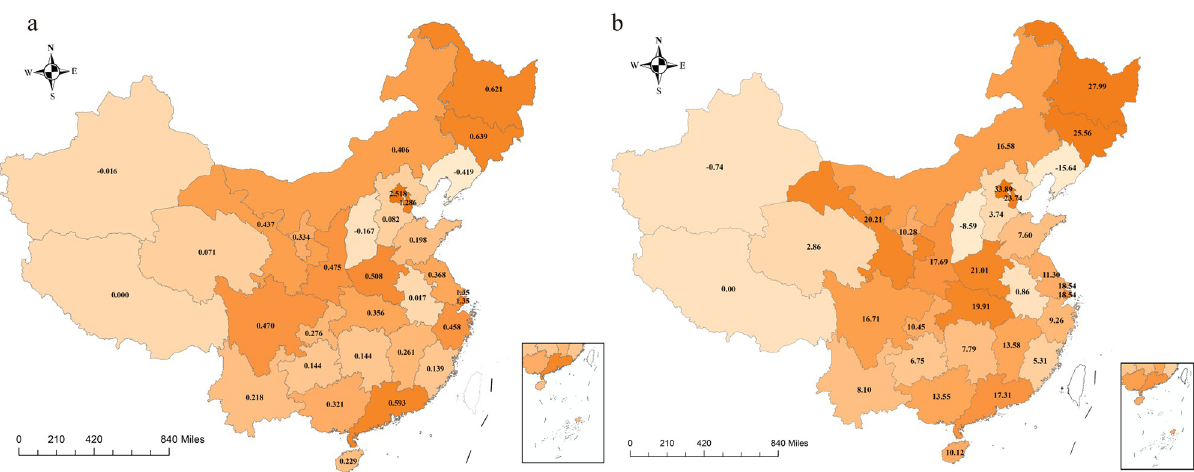
Fig 3. Accumulative impacts of COVID-19 on OEH visits per capita in mainland China. (a) This panel plots the total loss of OEH visits per capita from February 2020 to March 2021 by province. The darkness of each block represents the total loss of total OEH visits per capita of each province from February 2020 to March 2021 Tibet was excluded because of missing data. (b) This panel plots the relative loss of OEH visits per capita from February 2020 to March 2021 by province. The darkness of each block indicates relative loss of OEH visits per capita from February 2020 to March 2021 of each province, compared to the pre-pandemic level. Tibet was excluded because of missing data. Maps were created using ArcGIS by ESRI version 10.8 (http://www.esri.com) [21]. Base map sources were at http://bzdt.ch.mnr.gov.cn/ and https://dataverse.harvard.edu/dataset.xhtml?persistentId=doi:10. 7910/DVN/DBJ3BX. Detailed data utilized in the creation of this figure were from the Statistical Information Center of the National Health Commission of China (http://www.nhc.gov.cn/mohwsbwstjxxzx/s2906/new_list.shtml).